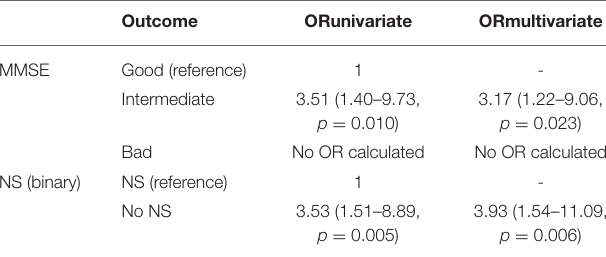
TABLE 4 | Univariate and multivariate logistic regression regarding